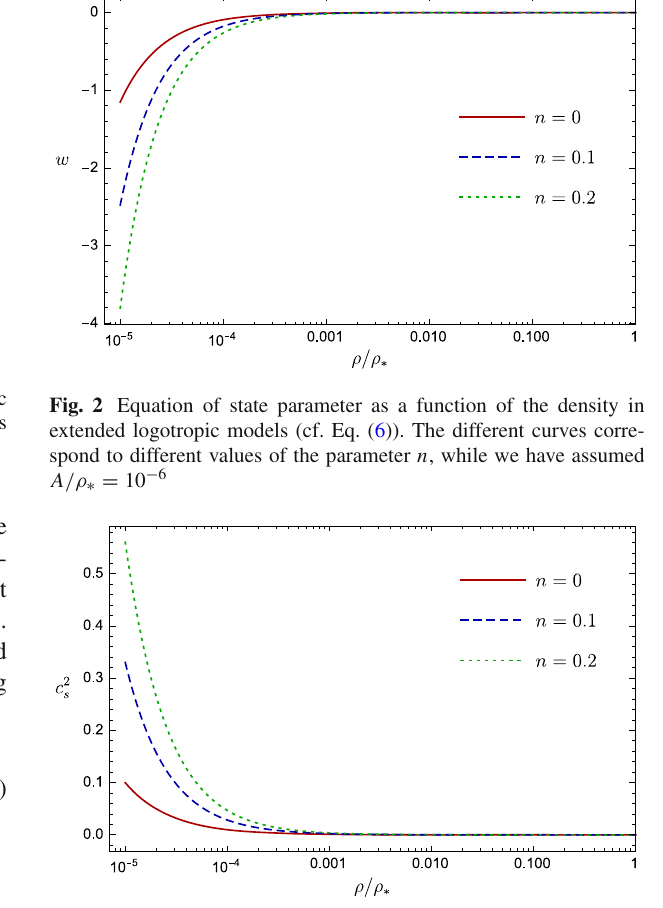
Fig. 3 Quadraticspeedofspeedasafunctionofthedensityinextended logotropic models (cf. Eq. (7)). The different curves correspond to dif- ferent values of the parameter n , while we have assumed A /ρ ∗ = 10 −